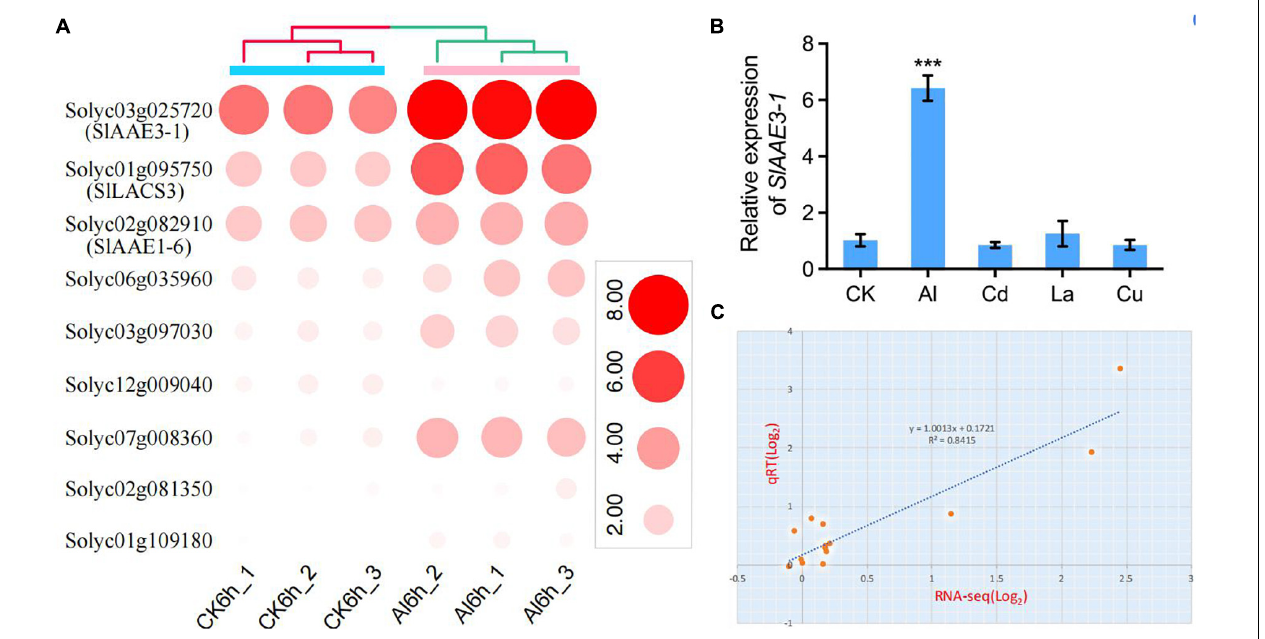
Frontiers in Plant Science |